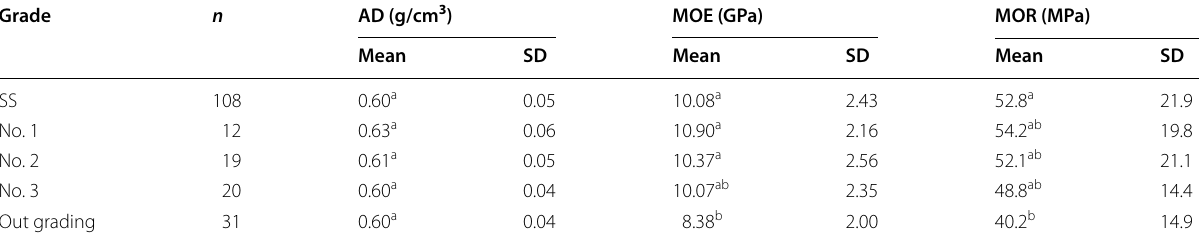
The same letters (a and b) followed by mean values indicate no significance at the 5% level according to the Tukey–HSD test n number of lumber pieces, AD air-dry density, MOE modulus of elasticity, MOR modulus of rupture, SD standard deviation, SS select structural